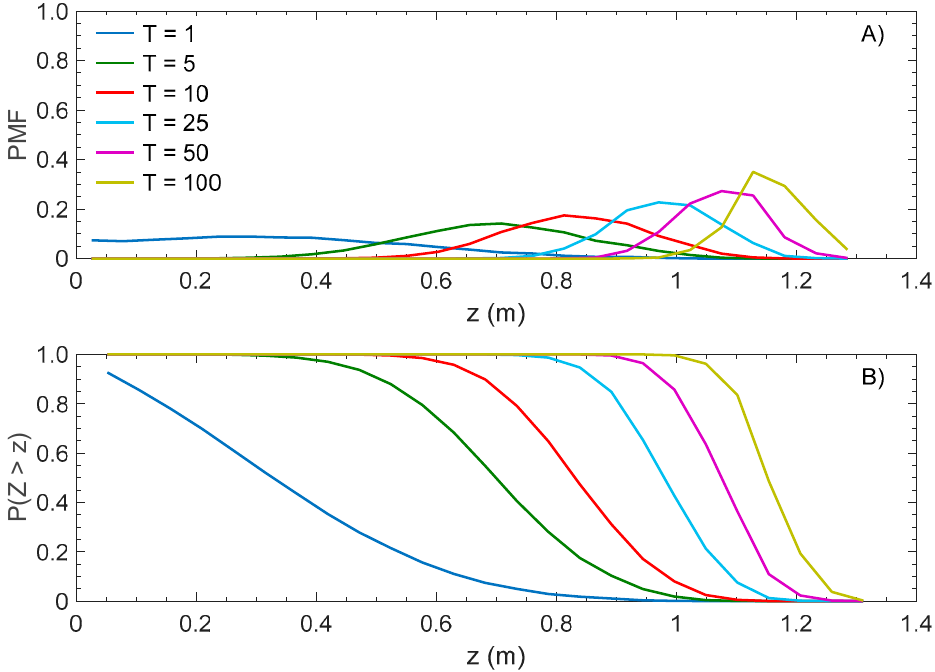
Figure 4. ( A ) probability mass function (PMF) of z in function of the considered bridge lifetime (T from 1 to 100 years). ( B ) Probability of exceedance of z in function of the considered time.